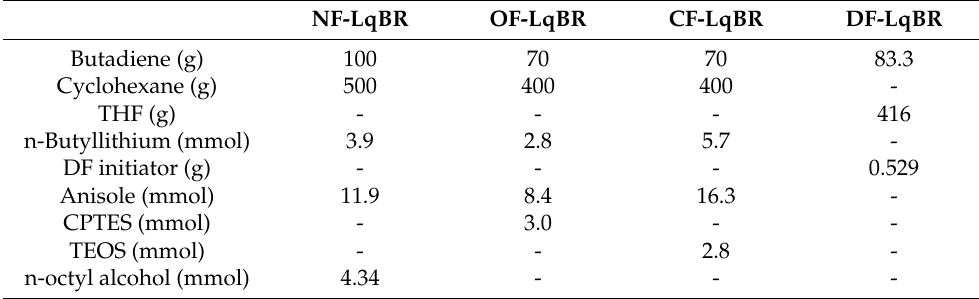
Table 1. Formulation for liquid butadiene rubber (LqBR)